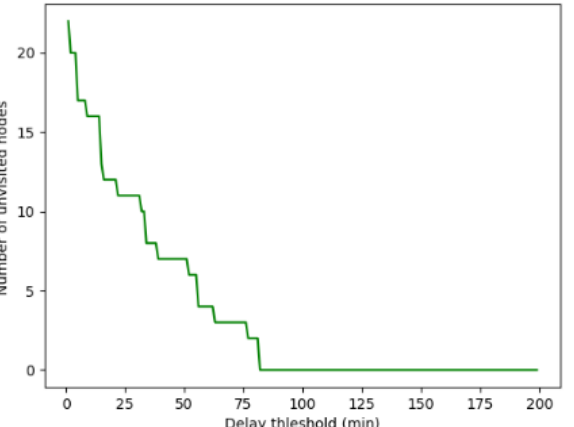
Figure 13. Variation of the number of unvisited nodes with respect to the delay